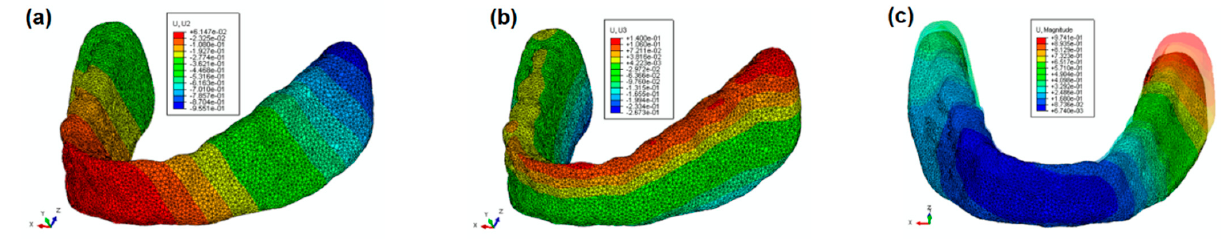
Figure 7. Displacements of the prosthesis along Y ( a ) and Z axis ( b ) during canine loading and simplified three-point pin support ( c ).